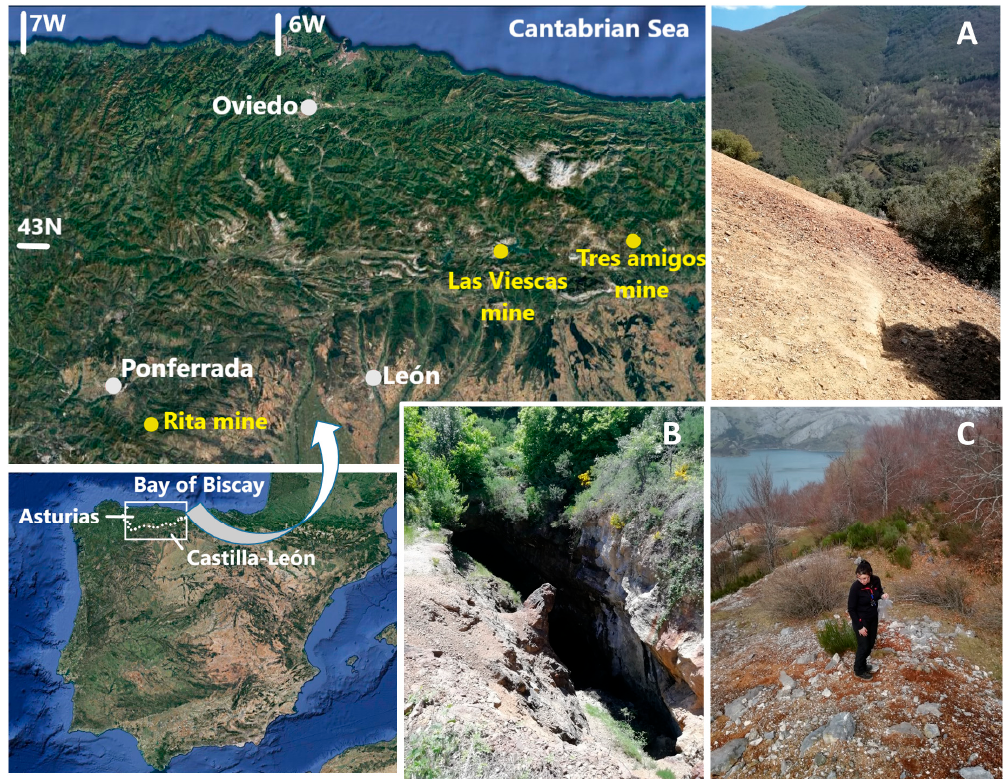
Figure 1. Location of main cities and mines cited in the text. ( A ) Spoil heap at Rita mine (Compludo, León); ( B ) Tres Amigos mine (Polentinos, Palencia); ( C ) spoil heap at Las Viescas mine (Riaño, León).